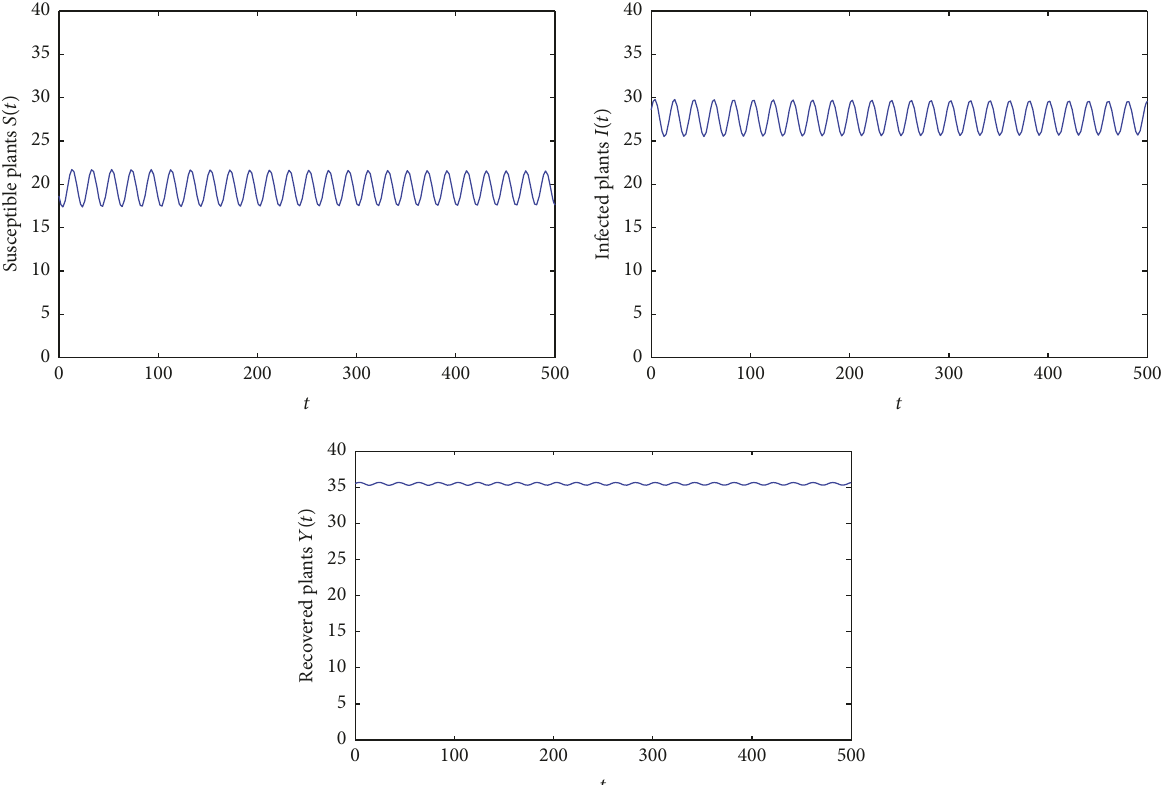
Figure 2: System (3) undergoes a Hopf bifurcation at the endemic equilibrium 𝐸 ∗ , where 𝜏 1 = 7.3 > 𝜏 ∗ 10 = 4.4686 and 𝜏 2 = 0 .